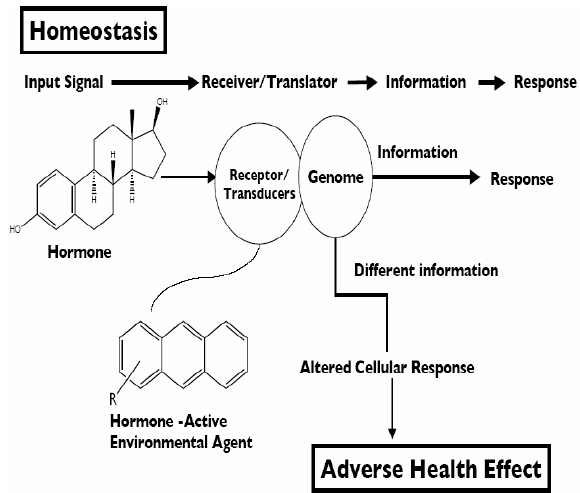
2: Indirect Environment-Gene Interaction : Hormones and vitamins interact with the genome via ligand-activated transcription factors yielding a “normal” cellular response to maintain homeostasis. Environmental agents can mimic natural ligands or bind to other intracellular receptors that yield different information from homeostatic regulation.